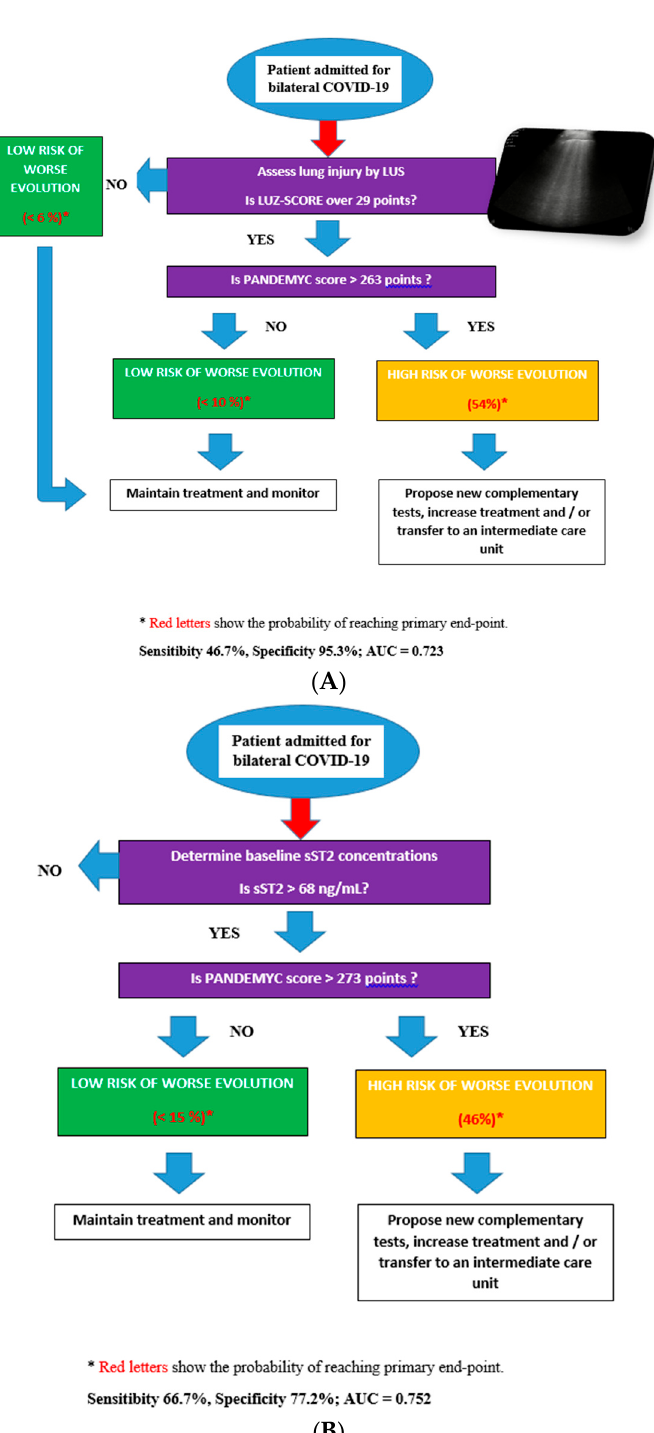
Figure 2. ( A ): Decisions diagrams proposed based on LUZ ‐ score and PANDEMYC score. ( B ): Decisions diagrams proposed based on sST2 and PANDEMYC score.